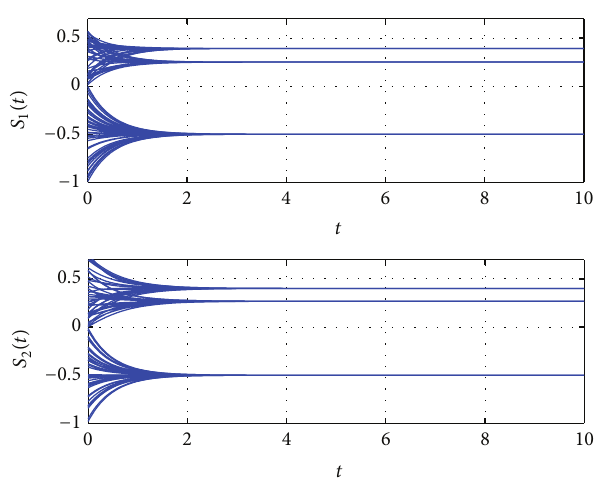
Figure7:Transientbehaviorof 𝑥 1 and 𝑥 2 neartheequilibriumpoint (−201/80, −5/8, −1/2, −5/16) 𝑇 in Example 1.